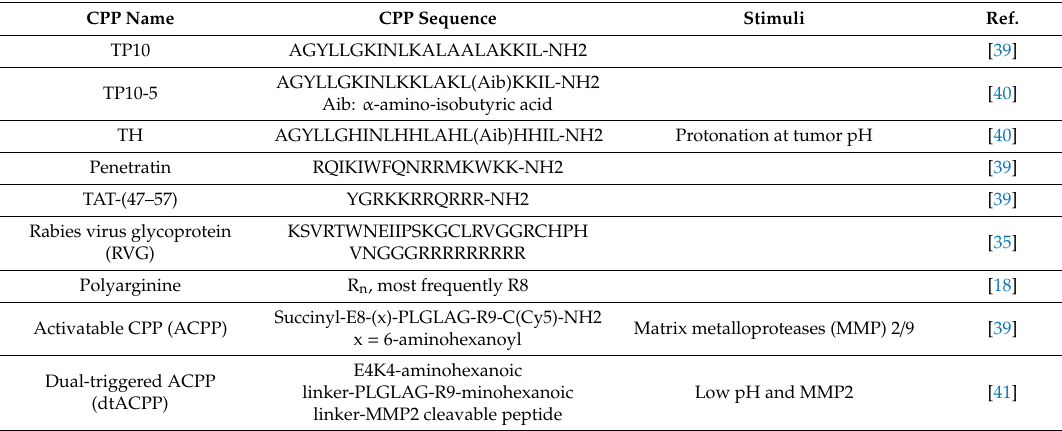
Table 1. Examples of conventional and stimuli-sensitive cell-penetrating peptides